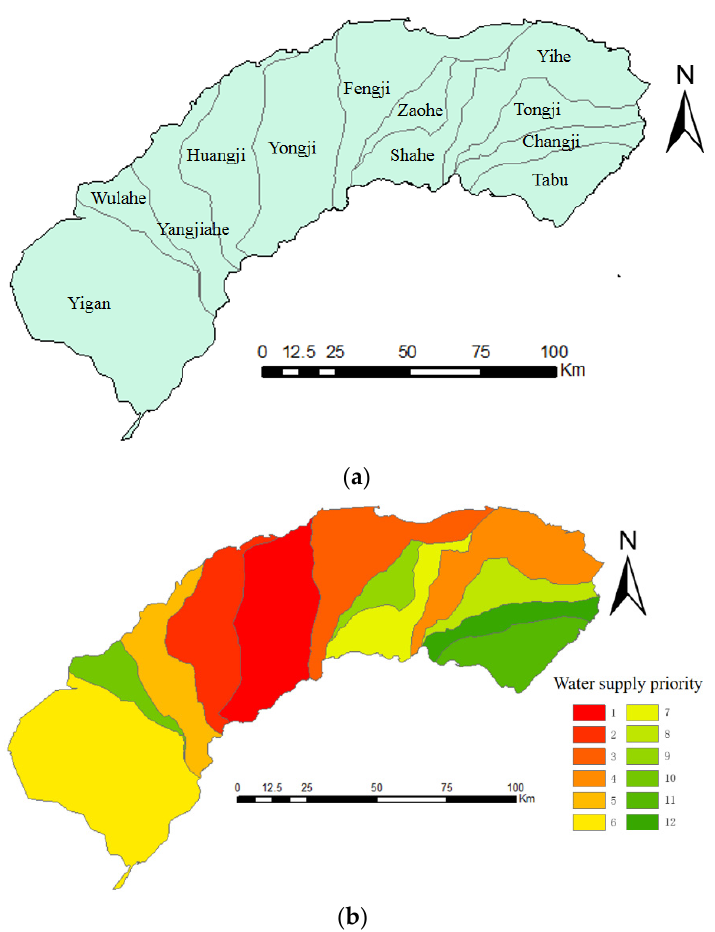
Figure 8. Evaluation results: ( a ) Water supply response unit; ( b ) water allocation priority.